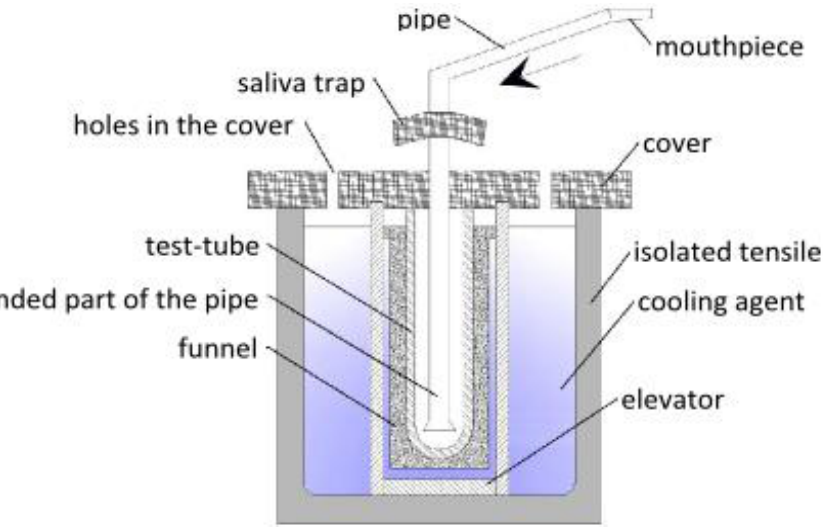
Figure 10. Diagram of the device constructed at the Medical University of